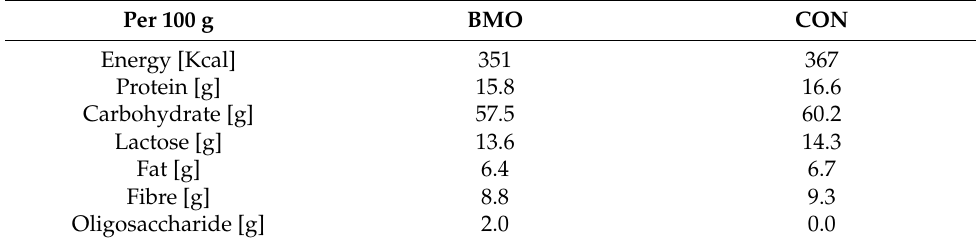
Table 1. Nutritional composition of the BMO and CON